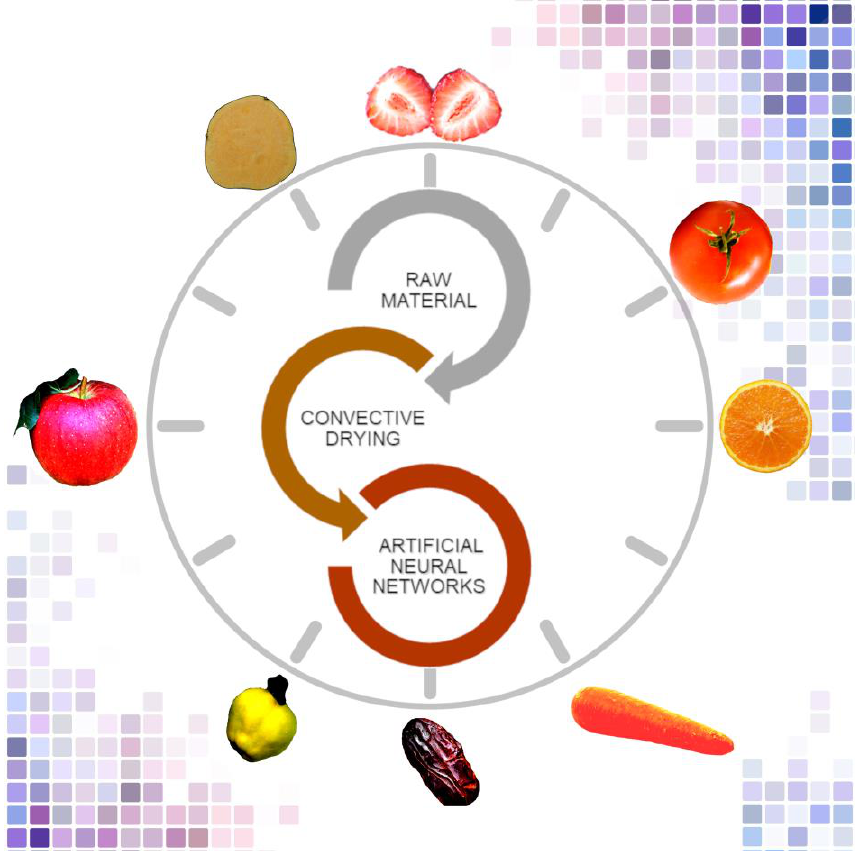
Figure 2. Convective drying supported by artificial neural networks.